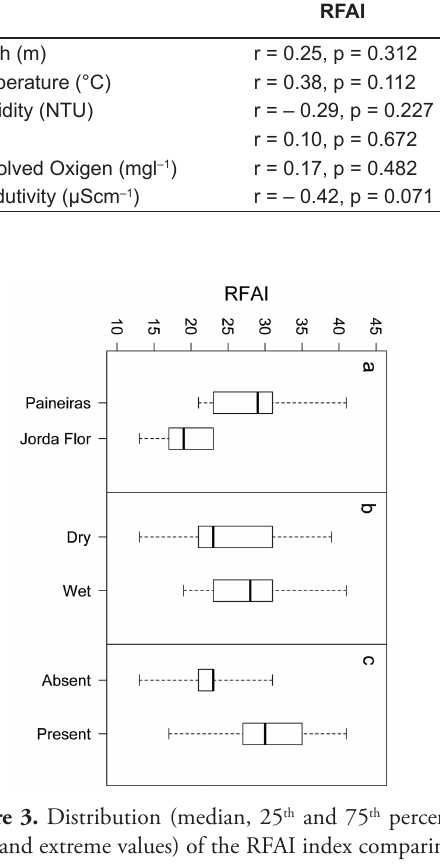
Mean RFAI (standard